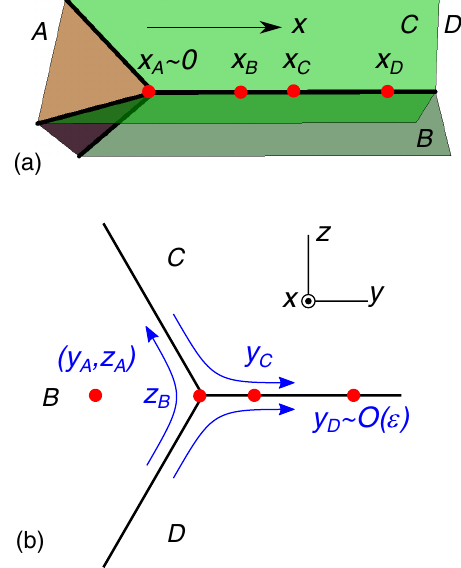
FIG. 15. Coordinate system for calculating the contribution to I when r are very close to the triple contact line BCD A;B;C;D (where y ¼ z ¼ 0 ). (a) and (b) show the same configuration from two different